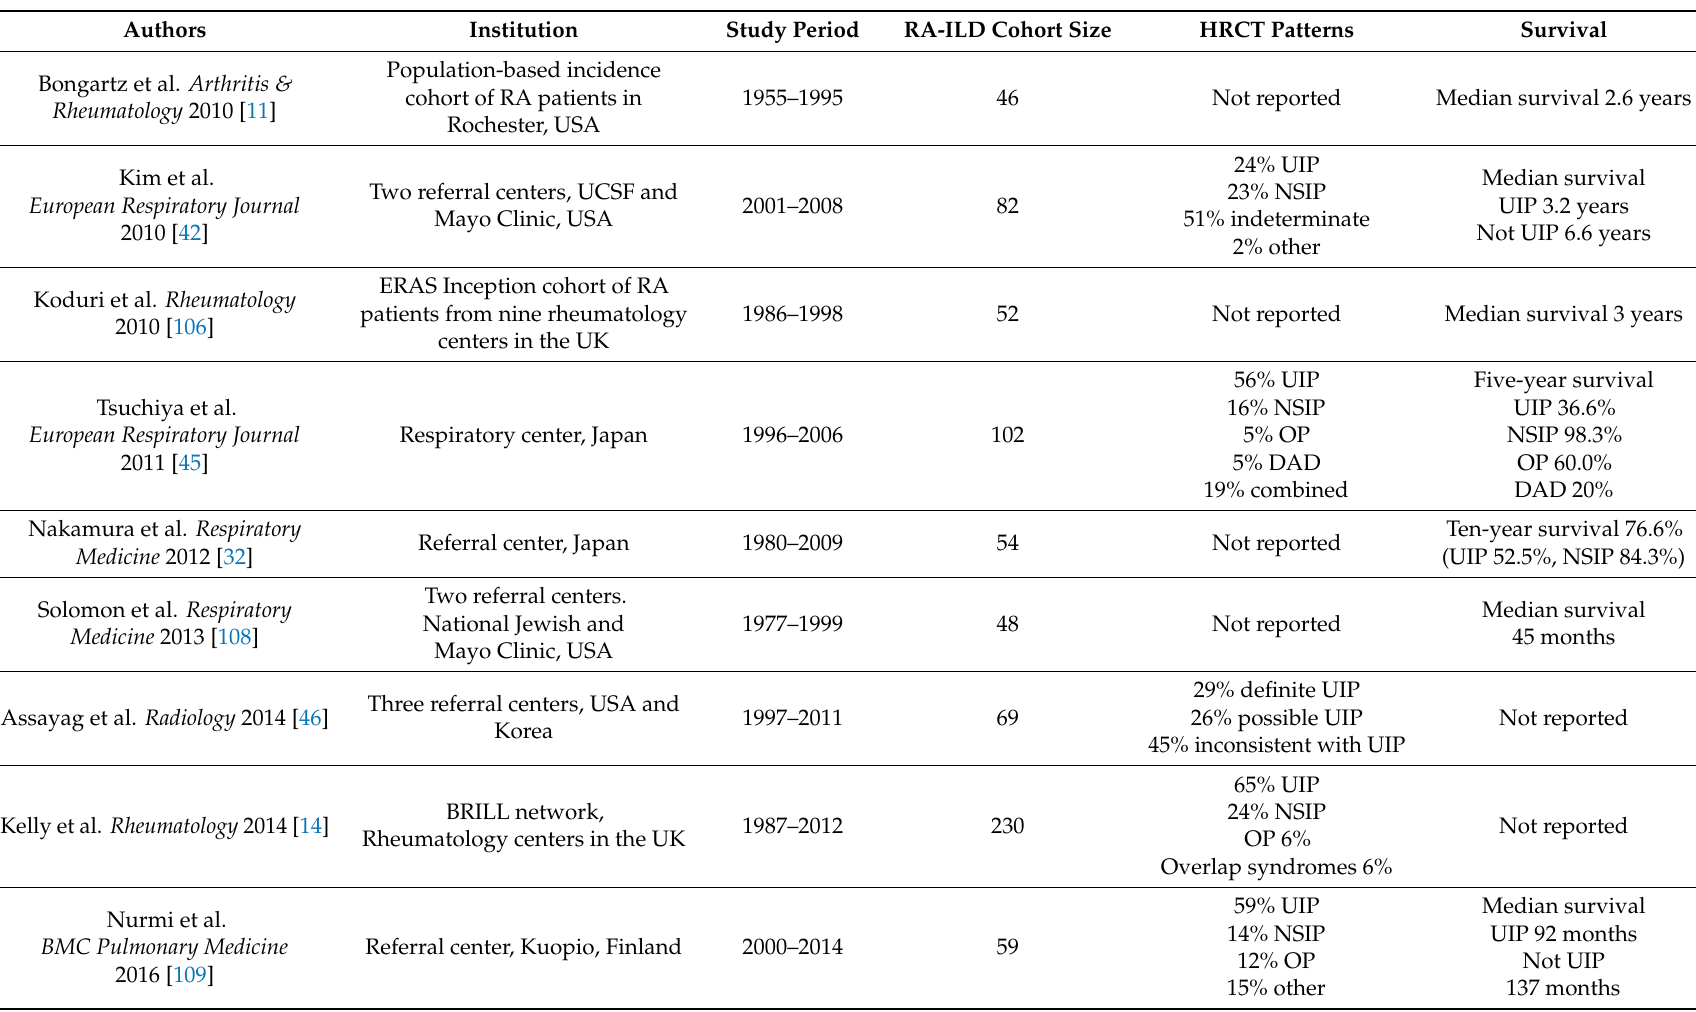
Table 4. Reported HRCT patterns and mortality in RA-ILD studies published between 2009 and